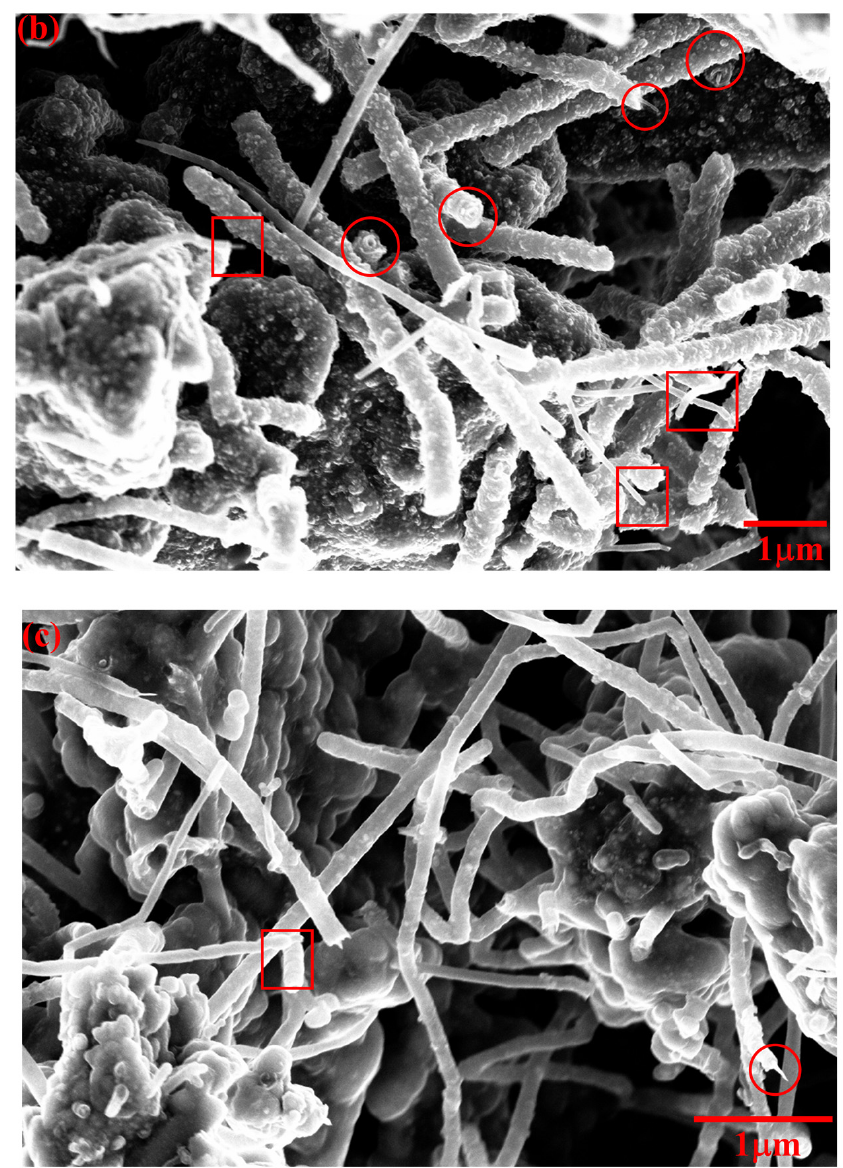
Figure 3. FE-SEM images of CNTs grown on cement clinker, with magnification of ( a ) 3000, ( b ) 30,000 and ( c ) 50,000 times. Cross sections of individual CNTs are red circled/squared.